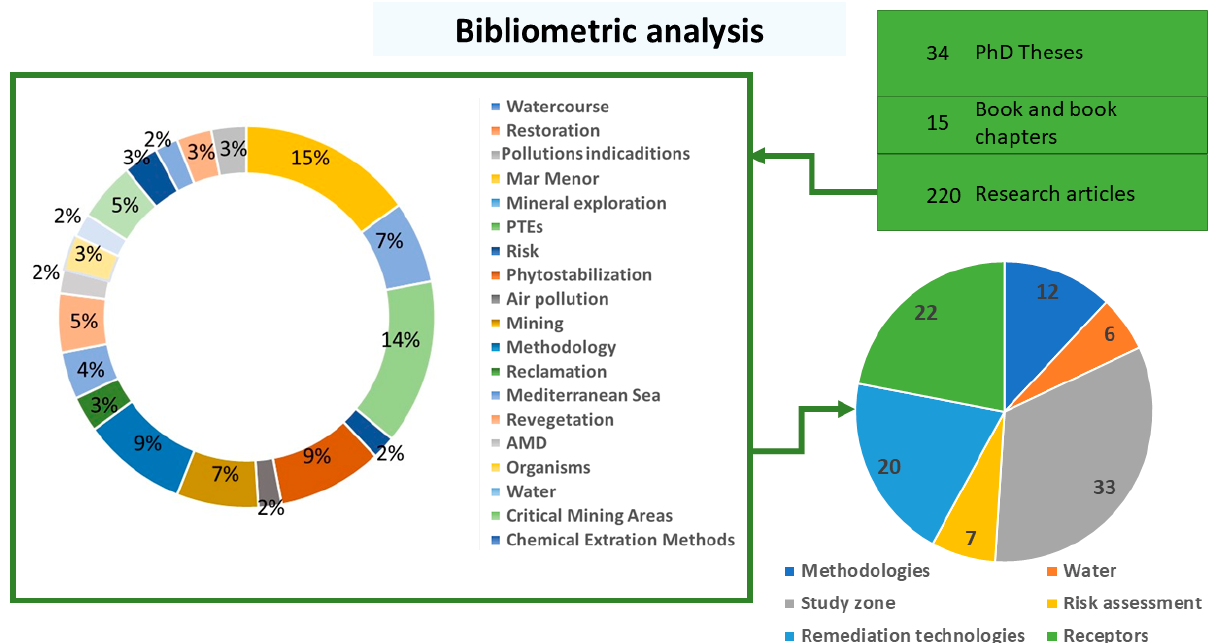
Figure 2. Summary of bibliometric analysis.